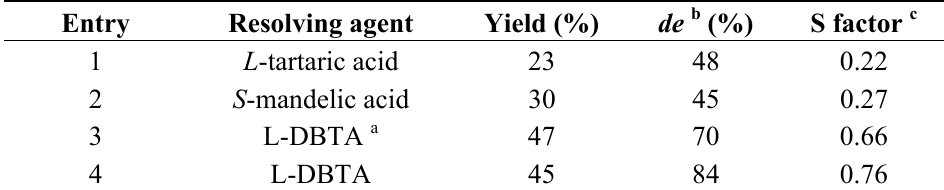
Table 1. Resolutions of (±)- 1 with chiral